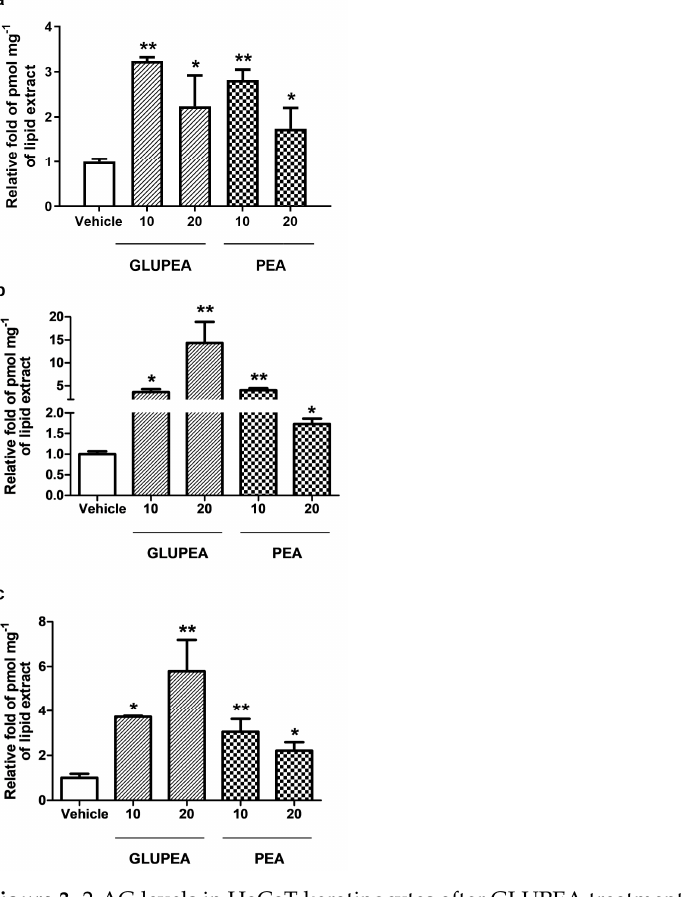
Figure 3. 2-AG levels in HaCaT keratinocytes after GLUPEA treatment. 2-AG levels were measured in HaCaT keratinocytes treated for 40 min ( a ), 6 h ( b ), and 24 h ( c ) with GLUPEA (10–20 µ M) or PEA (10–20 µ M). Data are representative of n = 8 separate determinations (means + s.e.m.) and expressed as the relative fold of pmol mg − 1 of lipid extract after normalizing for vehicle-treated cell values, considered as = 1. 2-AG levels measured in vehicle-treated cells were 8.32 ± 0.53 ( a ), 0.82 ± 0.06 ( b ), and 0.55 ± 0.10 ( c ). Statistical analyses were carried out using one-way ANOVA followed by the Newman–Keuls multiple comparison test (* p < 0.05, ** p < 0.01, versus vehicle). Table 1. Effects of GLUPEA on elevation of intracellular Ca 2+ through TRPV1 channels induced by